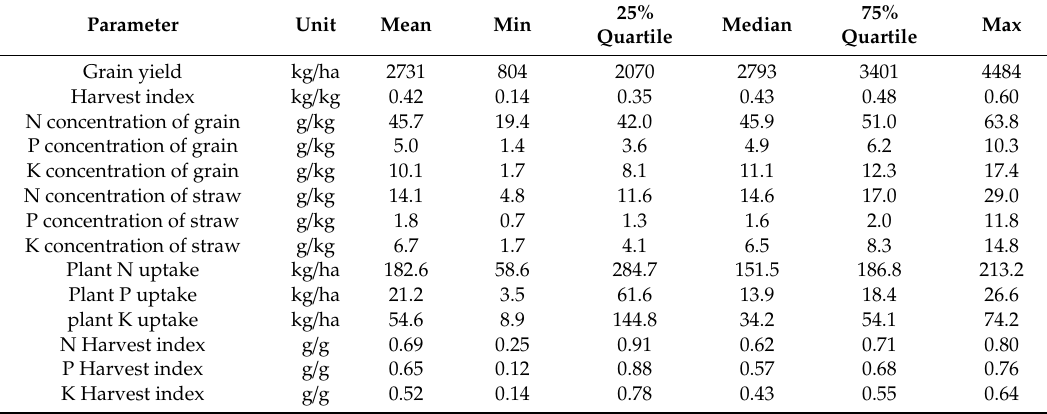
Table 1. Analysis of all soybean data from 29 experiment sites in Liaoning Province of China from 2011 to